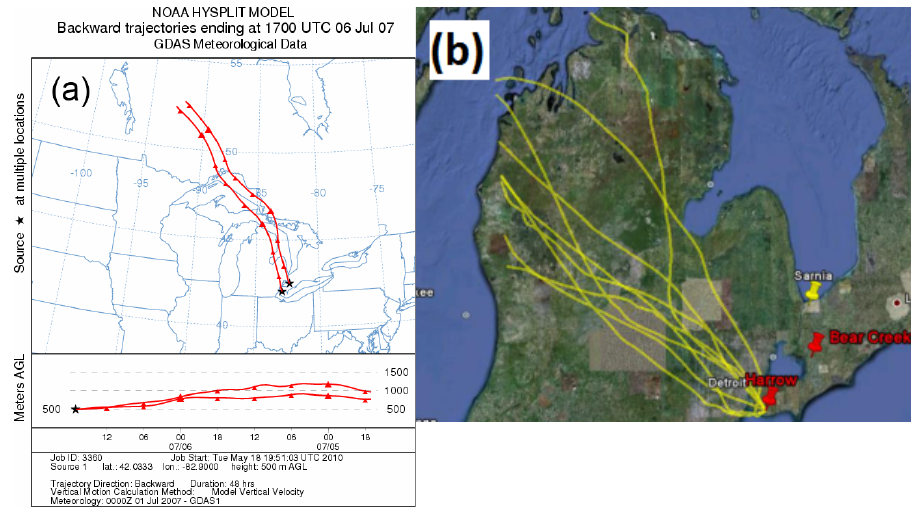
Fig. 6. Airmass sources during the Detroit/Windsor outflow period (see Fig. 3, blue period). (a) shows HYSPLIT back trajectories to the Harrow and Bear Creek sites. (b) shows high-resolution back trajectories to the Harrow site.